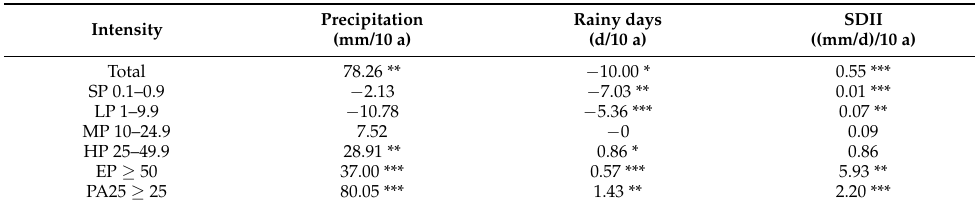
Figure 2. ( a ) Precipitation and ( b ) rainy days at each intensity level over the basin. The precipitation, rainy days, and simple precipitation intensity index (SDII ) trends over the Daning River from 1979 to 2017 are displayed in Table 1. Significant increasing trends were detected in the total precipitation and SDII, while a significant decrease oc- curred in the number of annual rainy days. A large, significant upward trend was detected for precipitation above heavy precipitation (PA25) (80.05 mm/10a, p < 0.01), leading to an increase in precipitation throughout the year. The rainy days with SP ( − 7.03 d/10a, p < 0.05) and LP ( − 5.36 d/10a, p < 0.01) showed obviously negative trends, with the annual total rainy days being dominated by a downward trend. It is worth nothing that both the rainy days and the SDII with EP showed large, significantly increasing trends. Table 1. Annual precipitation, rainy days, and SDII trends at each intensity level over the Daning River basin during 1979–2017.